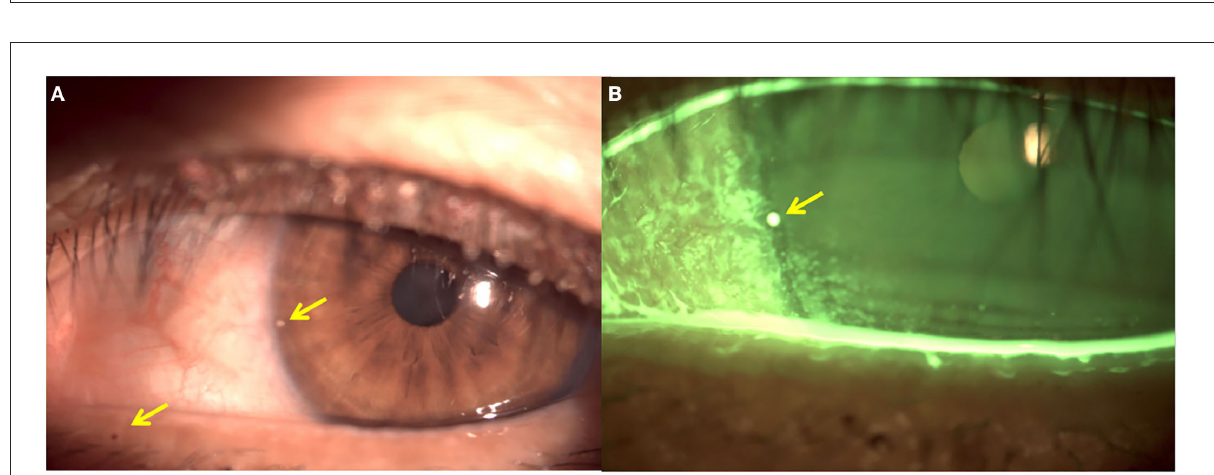
FIGURE3 Slit-lamp photographs of left eye before treatment. (A) Fecal matter (yellow arrows) on the lid margin and the surface of cornea. (B) Corneal epithelial defects, and fecal matter (yellow arrow) on the surface of cornea.